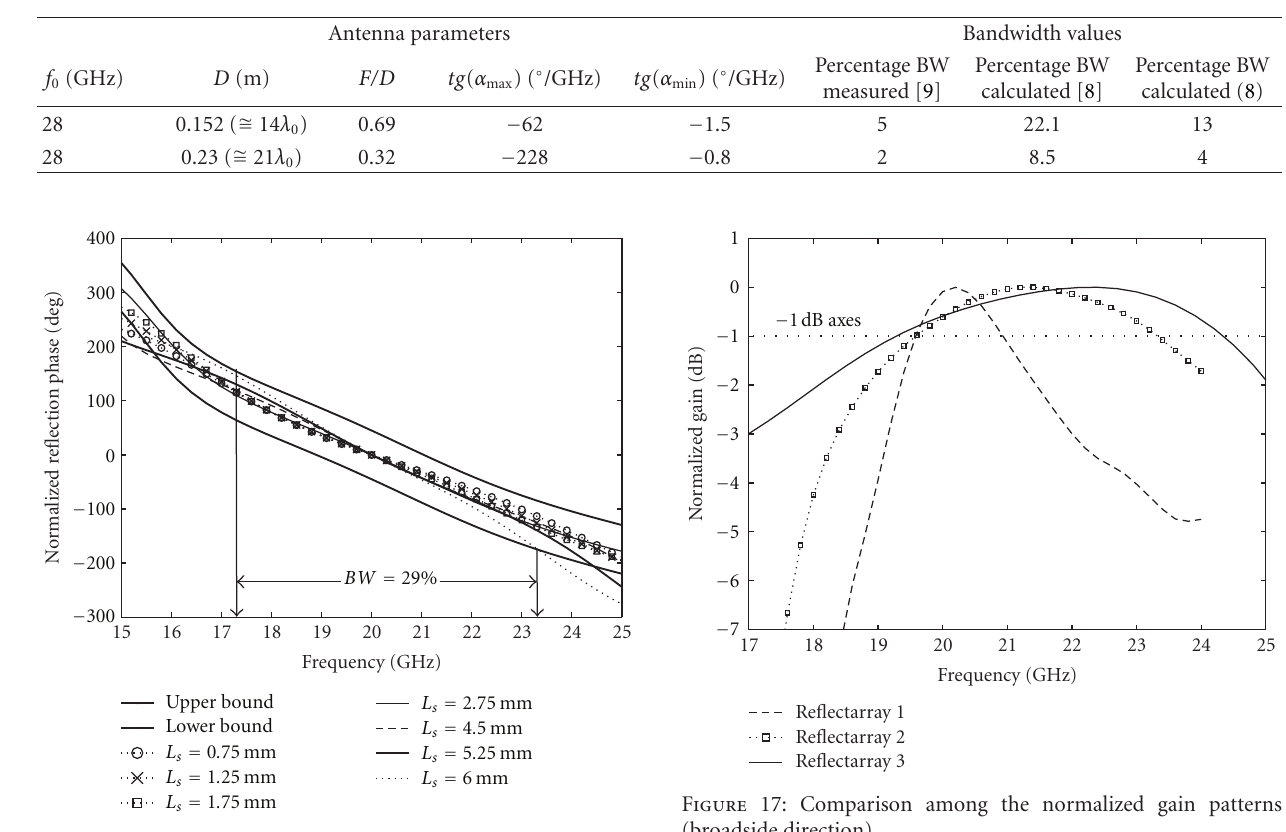
Figure 15: Calculated phase curves against frequency for various tuning line length.